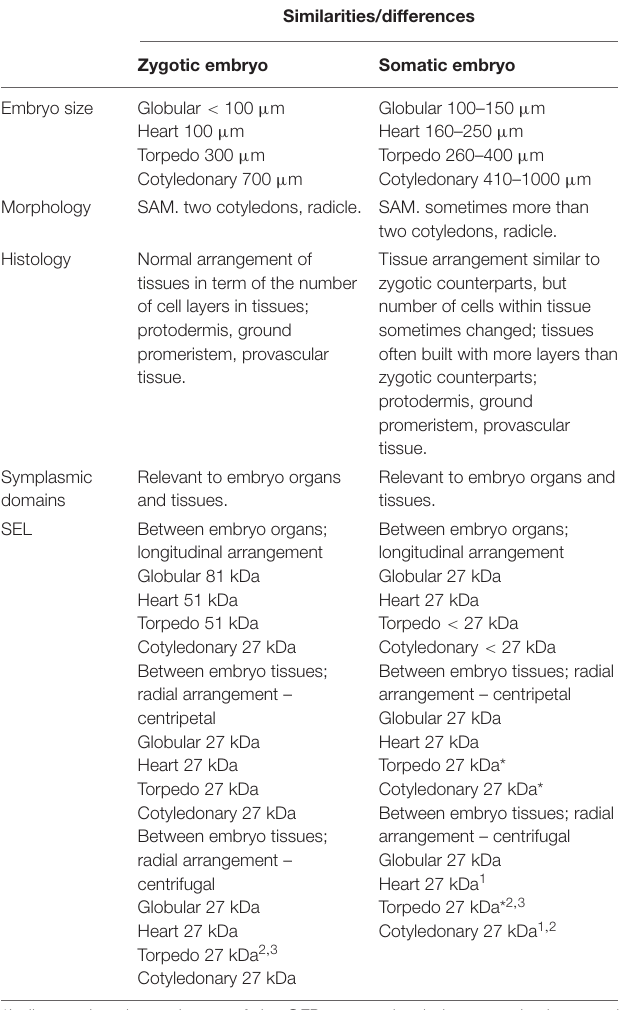
TABLE 1 | Characteristics and comparison of the zygotic and somatic